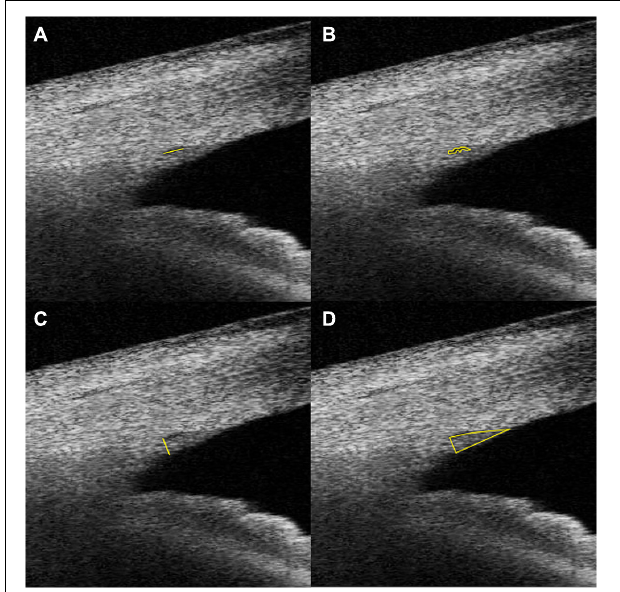
FIGURE 1 | Examples of SC diameter (A) , CSA (B) , TM height (C) , and TM area (D) measurements. SC, Schlemm’s canal; CSA, Schlemm’s canal